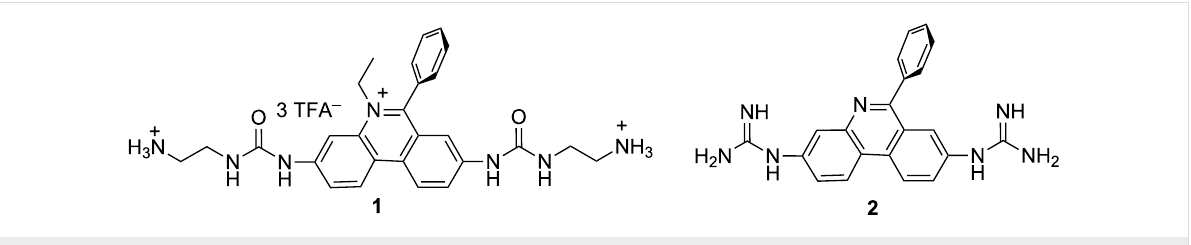
Figure 2: Urea and guanidine derivatives of EB with modified DNA interactions